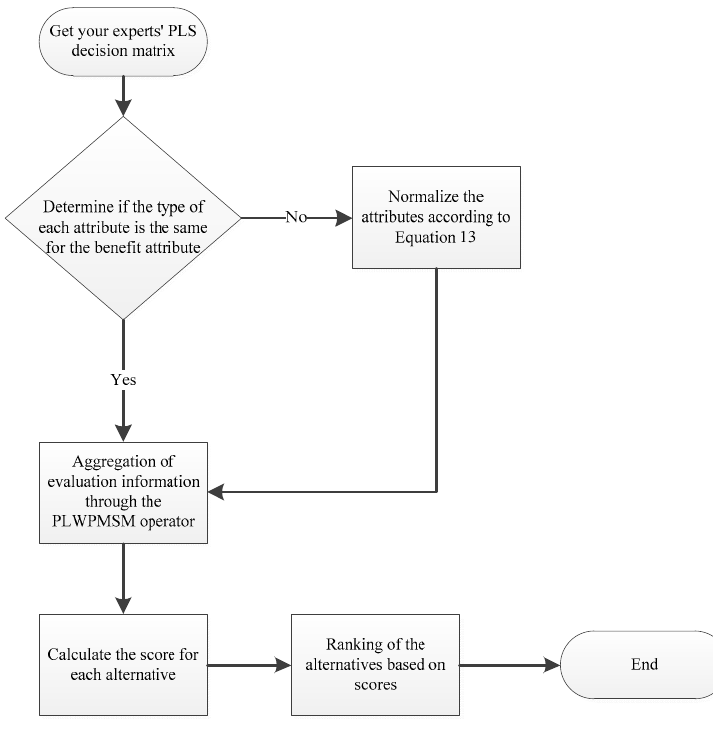
Figure 1. Decision diagram of the proposed method.